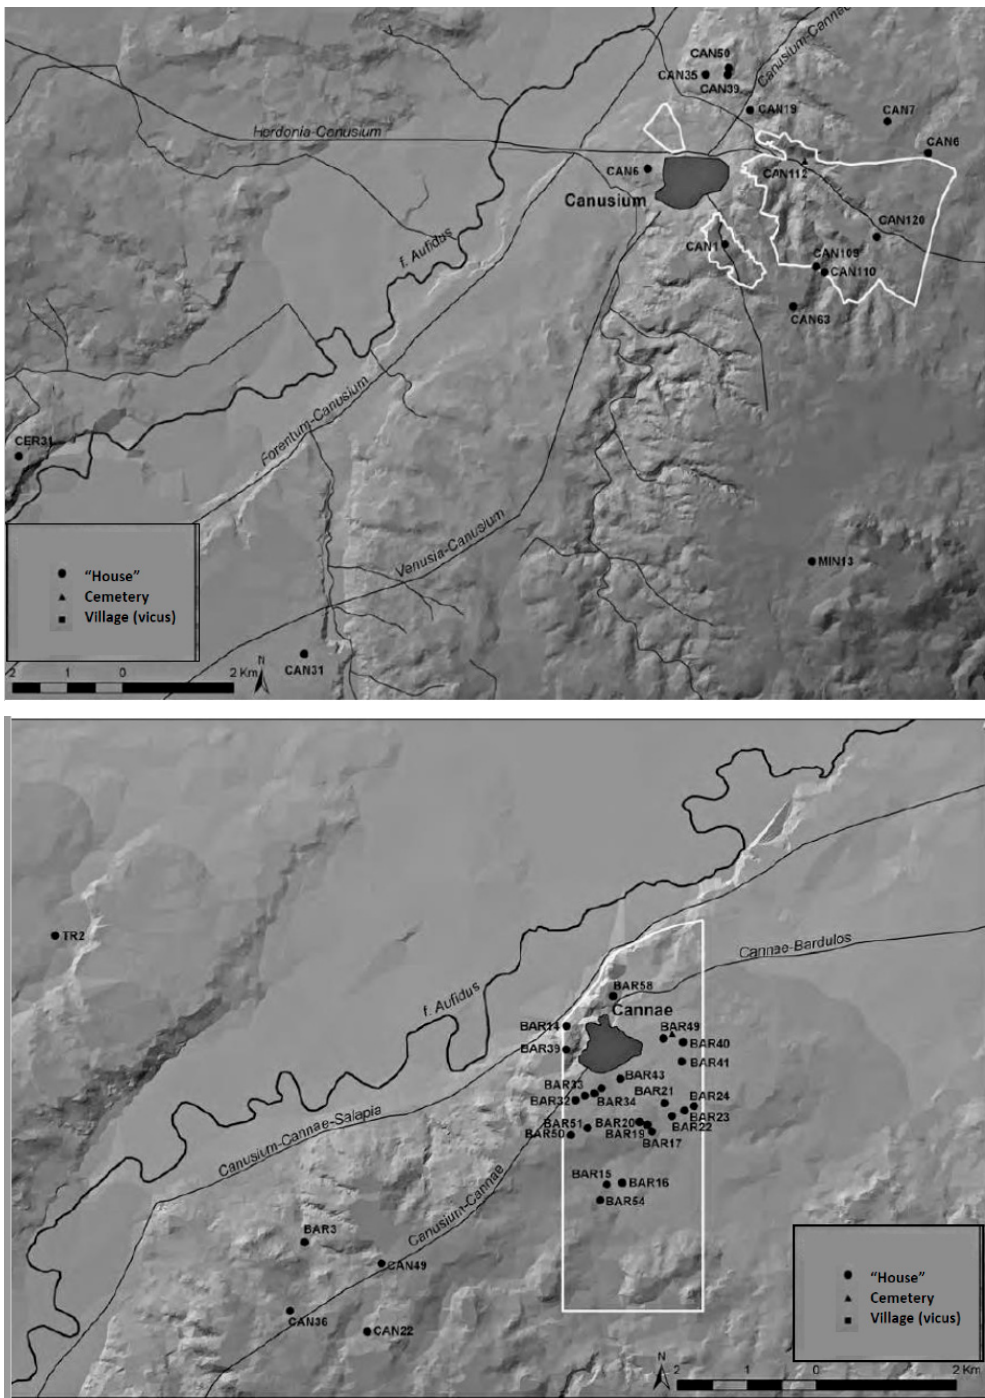
Figure 2. Sites around Canusium ( top ) and Cannae ( bottom ) identified in the Ofanto survey, sixth-late fourth centuries BCE (adapted from Goffredo 2010 with permission).